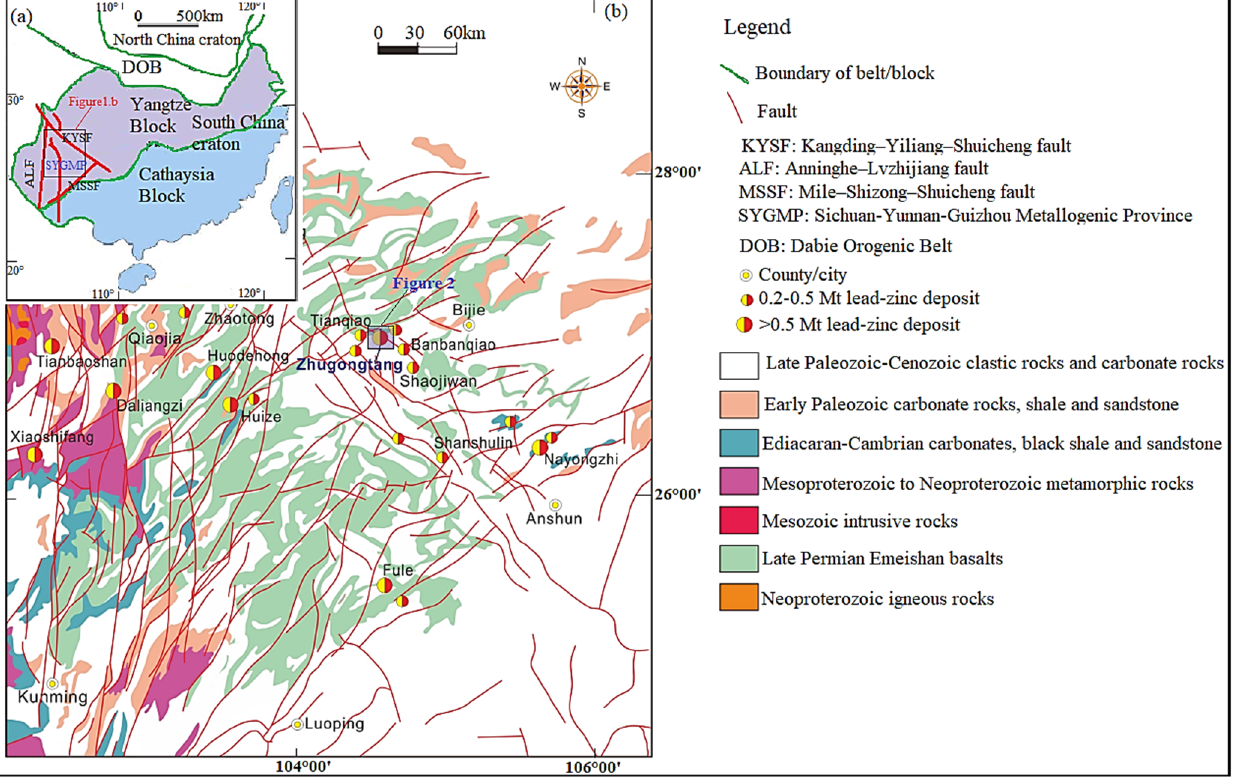
Figure 1. ( a ) Regional geological setting showing the location of the Sichuan–Yunnan–Guizhou Metallogenic Province (SYGMP) in South China; ( b ) geological sketch map of SYGMP showing regional structures, strata, and the distribution of lead–zinc deposits in the metallogenic province (modified from [35,45]).